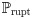
Visualization of ℙrupt for all AAAs in group 1.